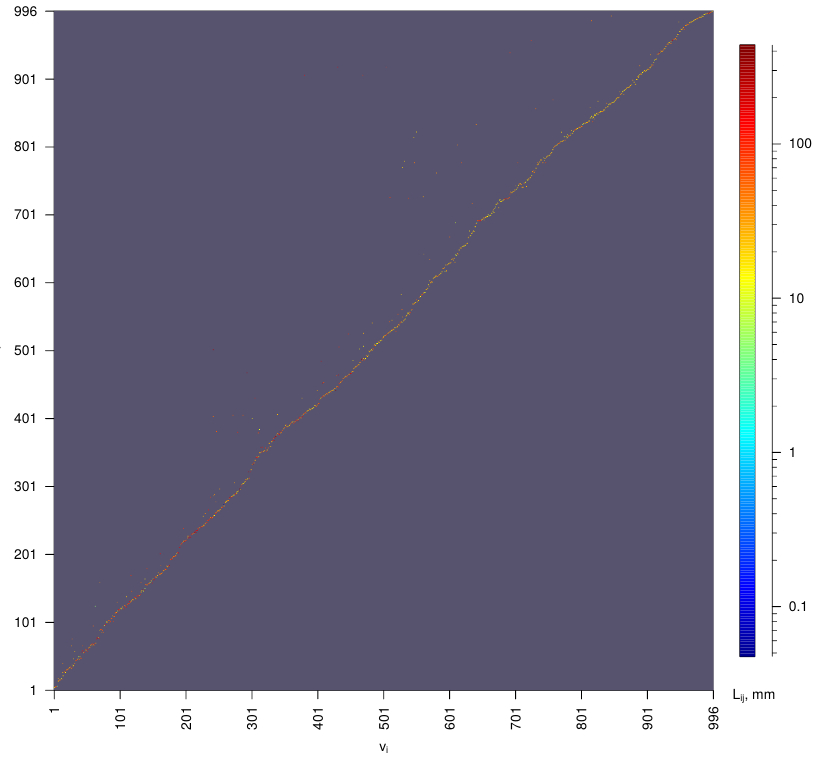
Figure 6. Adjacency matrix of the oriented data-based graph of human lymphatic system shown in Figure 5. Colors represent the lengths L ij of the edges e ij